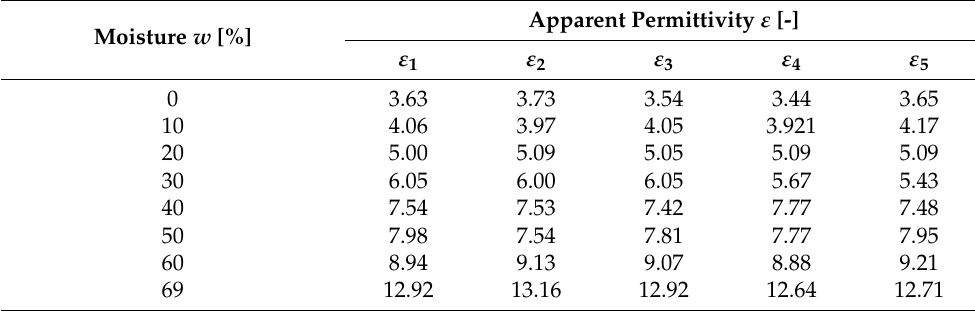
Table 2. Results of the apparent permittivity ε measurements with the S1 surface sensor for different values of moisture w ; 400 c.c. sample.